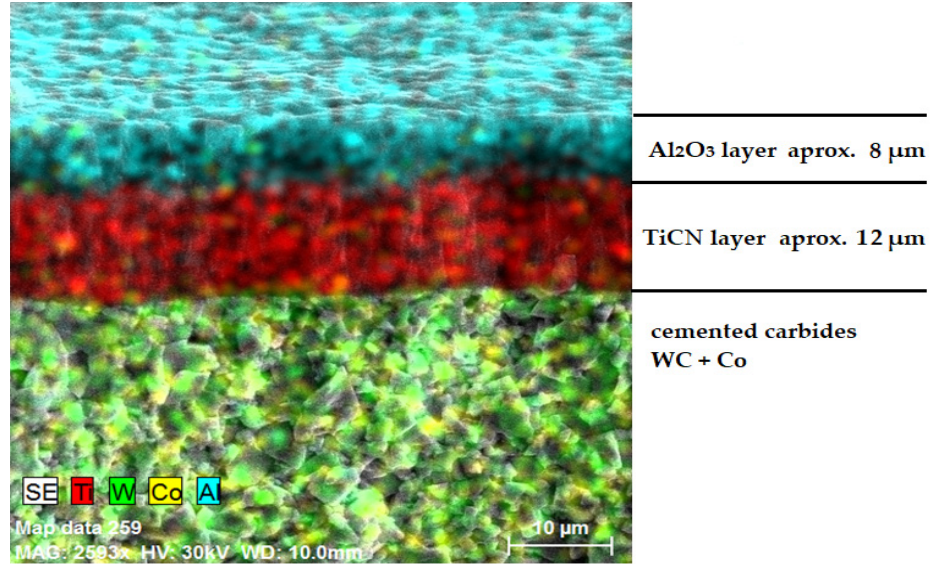
Figure 2. Coating thickness of CNMG 120408-PM 4315 carbide cutting insert.